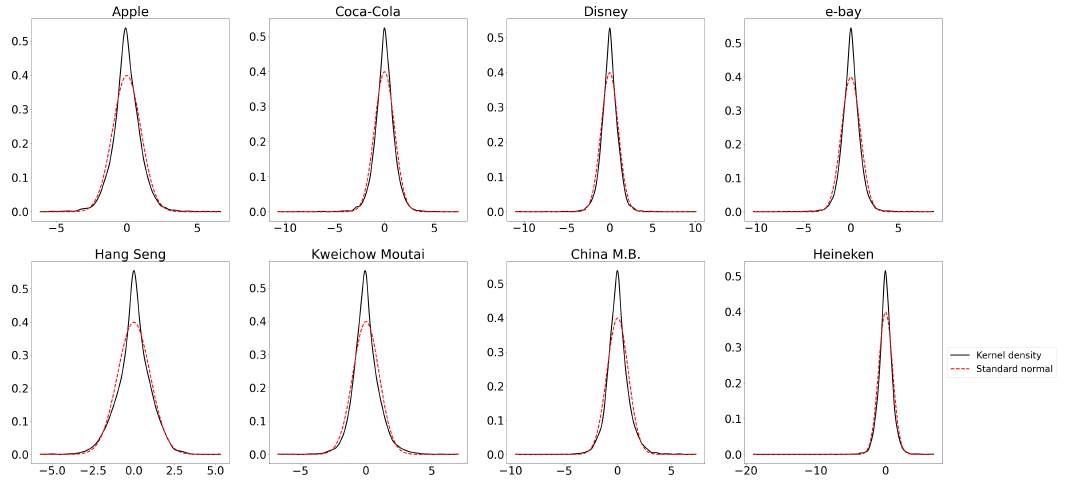
Figure 2. Kernel estimates of the probability density functions of the residuals ˆ Z t obtained with the normal model (part